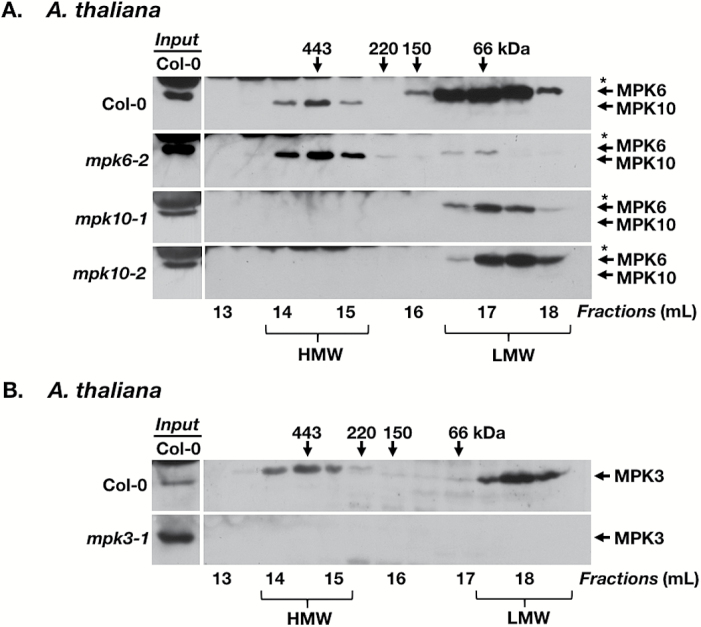
Identification of a MAP kinase-containing multiprotein complex in Arabidopsis thaliana. (A) GF/IB analysis of leaf extracts from A. thaliana ecotype Columbia-0 (Col-0, 1.5 mg of total protein), and the null mutants mpk6-2 (1.5 mg), mpk10-1 (0.5 mg), and mpk10-2 (0.5 mg). AtMPK6 and AtMPK10 were detected using anti-AtMPK6 antibody. (B) GF/IB analysis of leaf extracts from A. thaliana ecotype Col-0 (1.5 mg of total protein) and the mpk3-1 null mutant (0.75 mg). AtMPK3 was detected using anti-AtMPK3 antibody. Note: the Col-0 column on the left shows extracts (30 µg of total protein) from Col-0 as a reference for MPK6 (A) or MPK3 (B). These samples were analyzed on the same blot as the corresponding GF fractions, but additional bands were removed to adjust the elution profiles among panels. This is indicated by the white line that separates reference samples and GF fractions. For the two mpk-10 rows, shorter exposures for the Col-0 reference lane are shown as compared with the GF fractions. Numbers above and below the immunoblots are as described in Fig. 1. Immunoblots for Col-0 and mpk6-2 represent four independent experiments; and those for the two independent mpk10 mutant lines were performed once for each line.